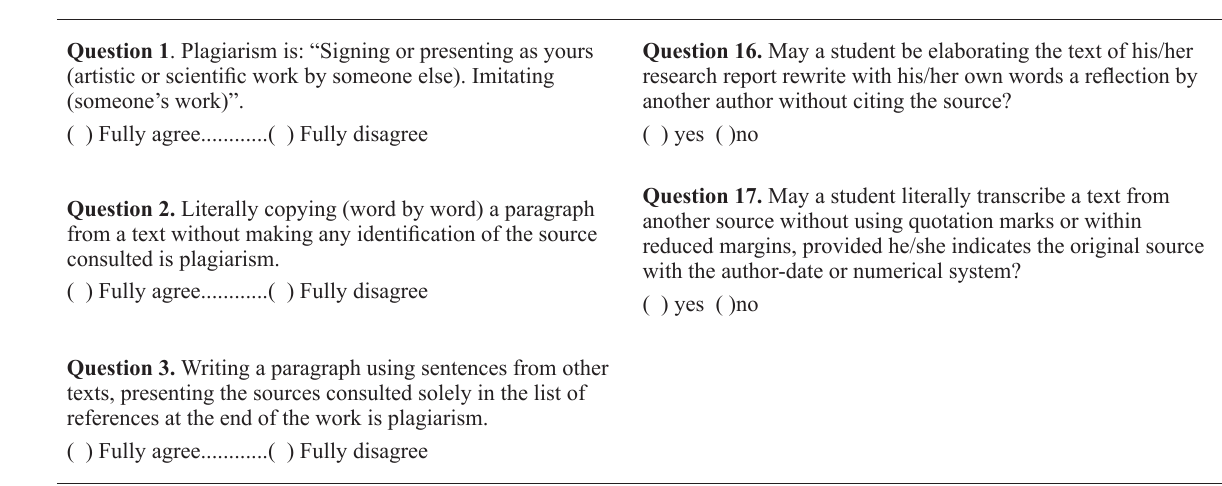
Questions in the questionnaire about theoretical and practical knowledge regarding academic plagiarism. Theoretical-conceptual knowledge Analysis and practical interpretation